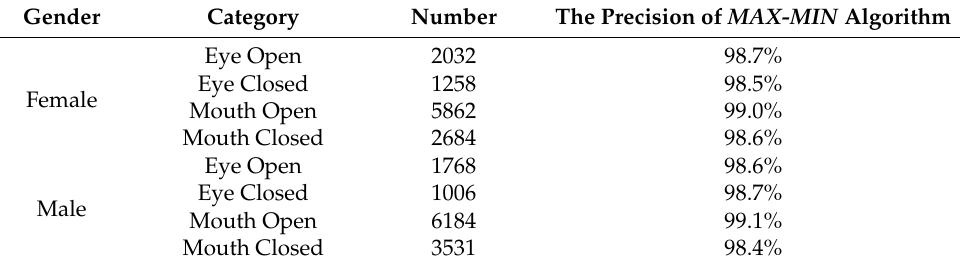
Table 2. Precision of detection of different states based on MAX-MIN algorithm. Gender